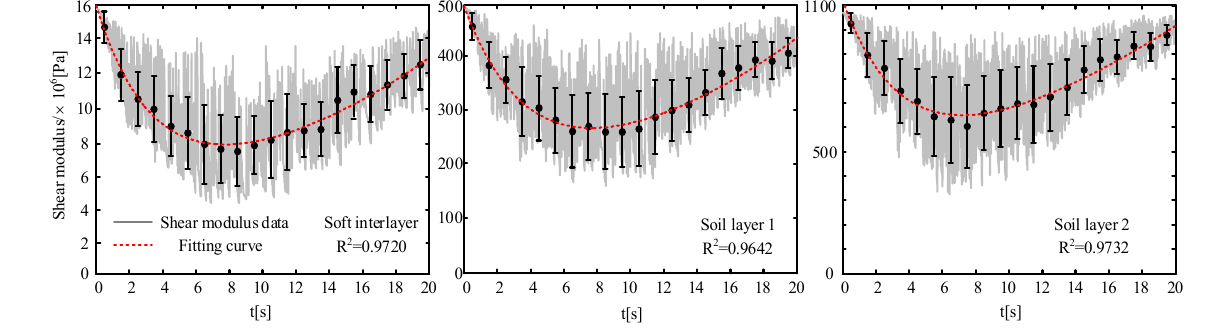
Figure 7. Shear modulus time-histories of various soils.